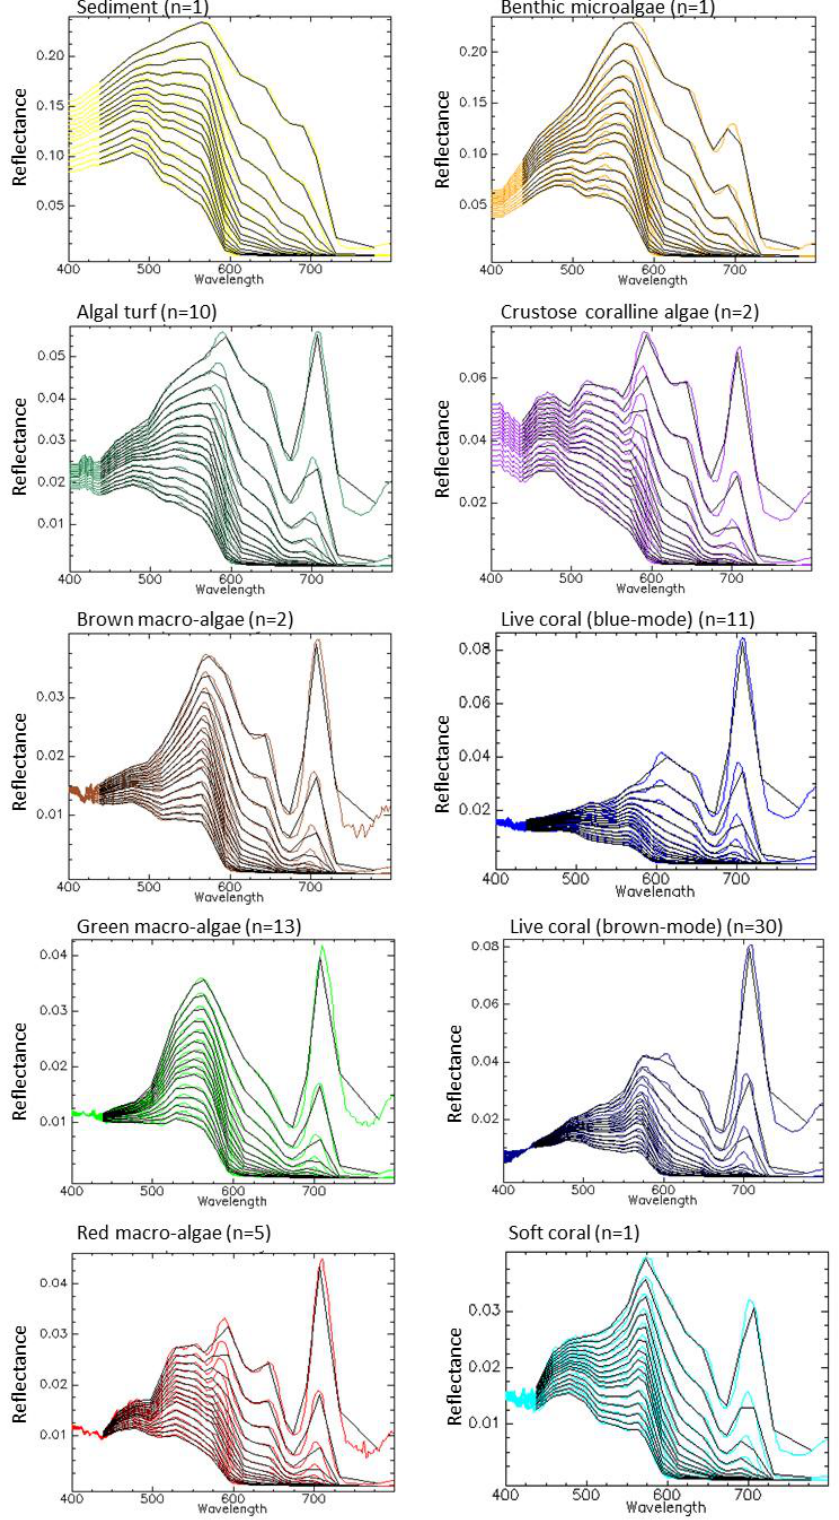
Figure 3. Subsurface reflectance curves for each benthos and substrate type at depths 0.5, 1.0, 1.5, 2.0, 2.5, 3.0, 3.5, 4.0, 4.5, 5.0, 6.0, 7.0, 8.0, 9.0, and 10.0 m. The coloured lines represent the full resolution (400–800 nm) spectra, the black lines represent the correspond curves integrated across the CASI-2 spectral response curves. Note that the scale of the y-axis changes between plots, to allow the shape of the spectra be better